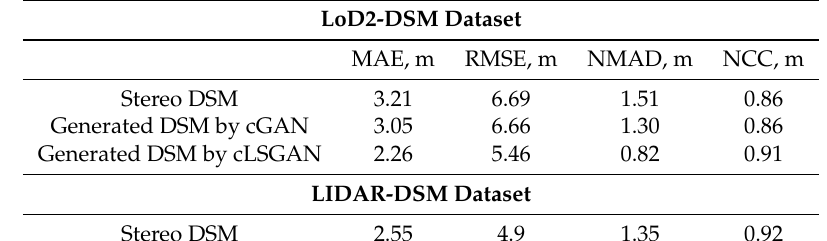
Table 1. Prediction accuracies of cGAN and cLSGAN models on all investigated metrics for LoD2-DSM and LIDAR-DSM datasets over the Berlin area.